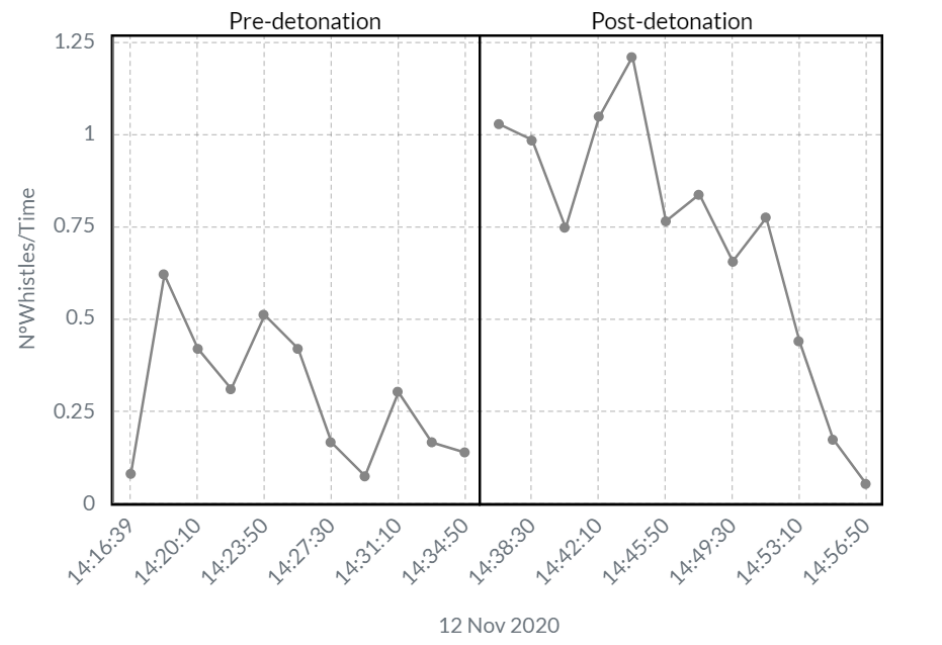
Figure 7. Evolution of bioacoustic activity in the function of time, considering a time window of 110 s and evaluated in the 20 min before and after the explosion.